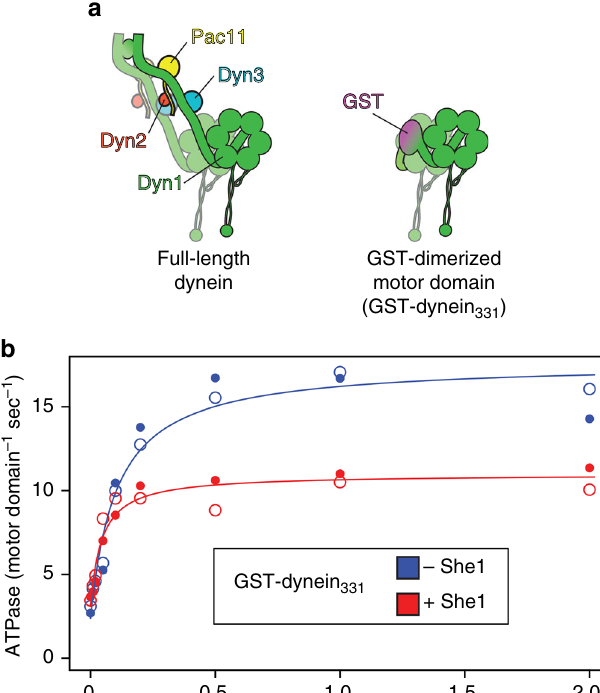
Fig. 1 She1 reduces dynein microtubule-stimulated ATPase activity, and enhances the af fi nity of dynein for microtubules. a Cartoon representation of the full-length dynein complex (left, with associated accessory chains; Dyn2, dynein light chain; Dyn3, dynein light-intermediate chain; Pac11, dynein intermediate chain; Dyn1, dynein heavy chain), and the minimal GST-dimerized dynein motor domain (right). b , c Microtubule-stimulated ATPase activity in the absence (blue) and presence (red) of 200 nM She1. Data points from two replicate experiments are shown (open and closed circles). Data were fi t as described in Methods to obtain the basal ( k basal ; microtubule-unstimulated ATPase activity) and maximal ( k cat ; microtubule- stimulated) ATPase rates, and the microtubule concentration at which half- maximal ATPase activation is achieved ( K m (MT) ), all of which are depicted in c (error bars, standard error of the fi t). d Dissociation rates ( k off ) of GST – dynein 331 in the absence and presence of increasing She1 concentrations. Off rates represent the inverse of the time constant from exponential fi ts to dwell-time distributions as reported in Fig. 6g (error bars, standard